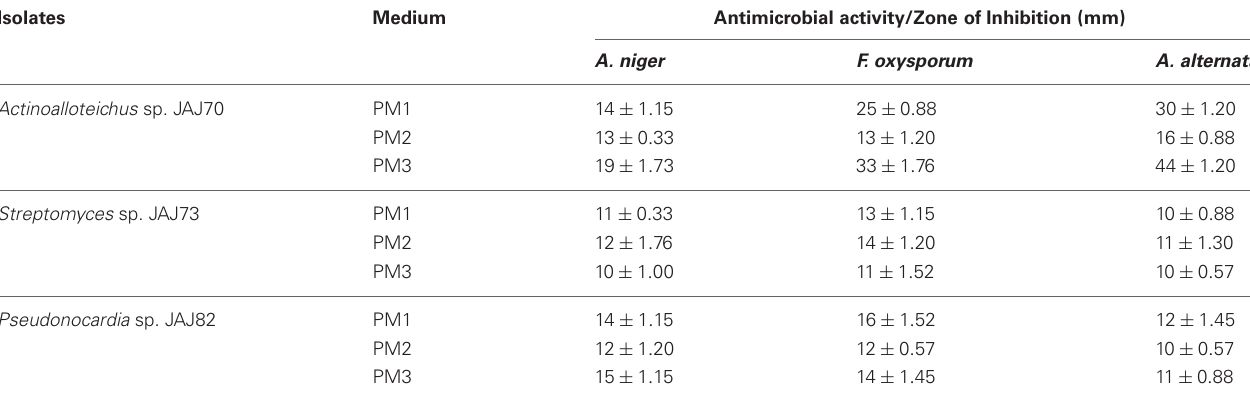
Table 3 | Antifungal activity of saltpond actinomycete isolates against three test fungi.